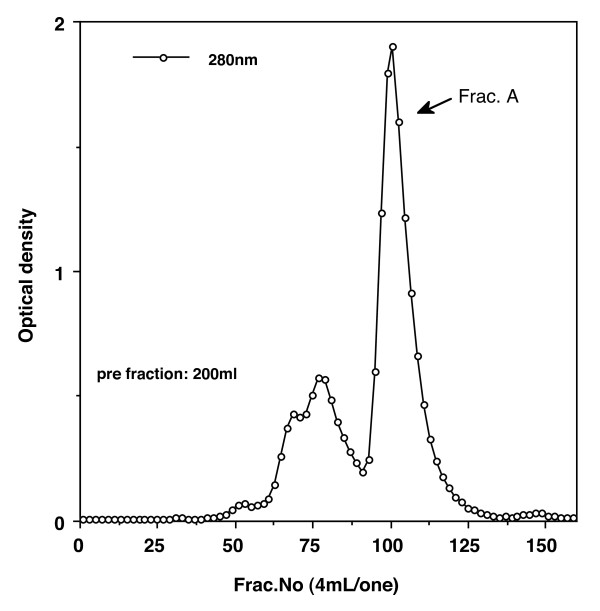
Results of Sephacryl S-200 HR column (5.0 × 100 cm) gel filtration of the CM Fr-1 peak in Figure 1. The main peak (Fr. A) proved to contain chicken CA-III. Starting buffer: 0.05 M Tris-HCl (pH 8.0) containing 0.5 M NaCl. Absorbance values were read at 280 nm. Flow rate: 20 mL/h.